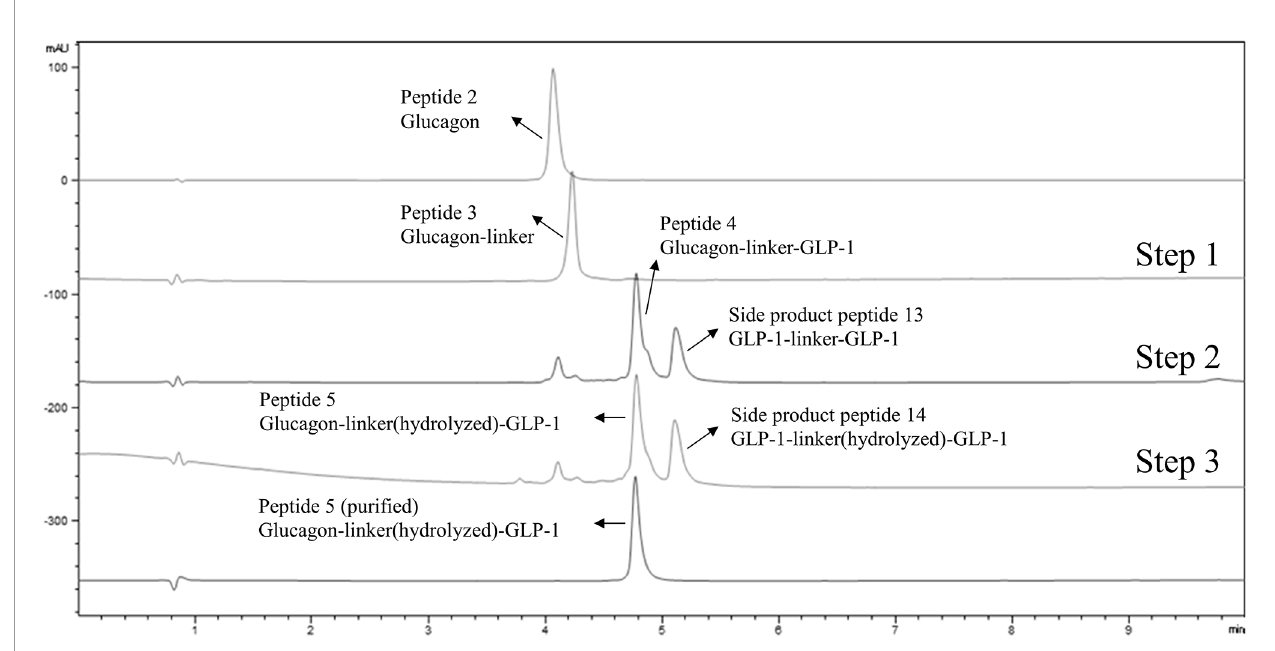
FIGURE 1 | LC-MS analysis of one-pot heterodimerization in three steps. From top to bottom, the fi rst line shows the UV absorption trace of a puri fi ed cysteine containing glucagon analog (peptide 2); the second line is the UV absorption trace of a glucagon analog-linker adduct (peptide 3) in the reaction mixture following the fi rst step reaction; the third line shows the UV absorption trace of glucagon-linker-GLP-1 analog adduct (peptide 4) in the reaction mixture after the second step reaction, along with a minor side-product 1 representing GLP-1-linker-GLP-1 analog; the fourth line shows the UV absorption trace of the glucagon-linker (hydrolyzed)-GLP-1 adduct analog (peptide 5) in the reaction mixture following the third reaction step, along with a minor side product 2 of GLP-1-linker(hydrolyzed)- GLP-1 analog; the fi fth line shows the UV absorption trace of puri fi ed peptide 5 glucagon-linker(hydrolyzed)-GLP-1 analog adduct after HPLC puri fi